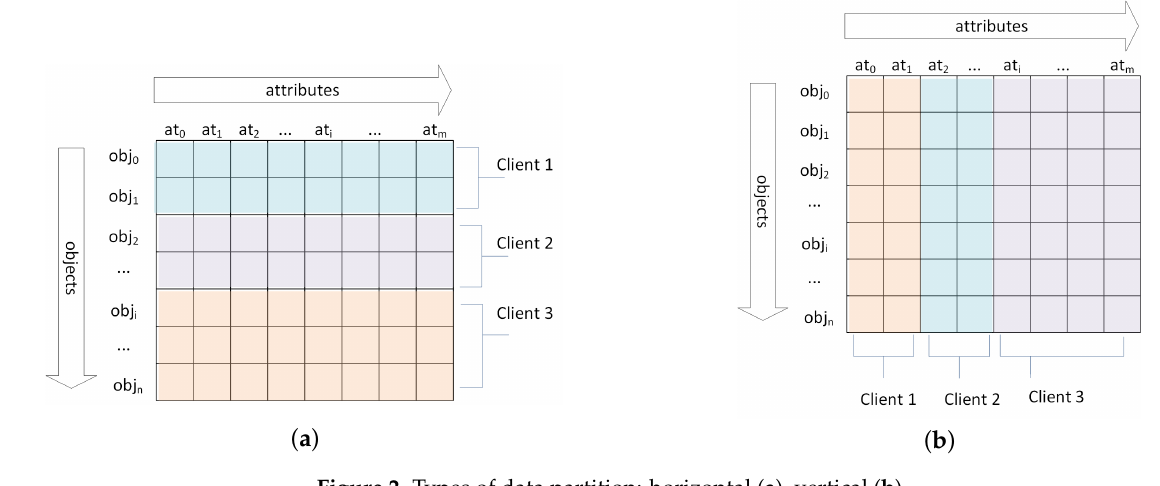
Figure 2. Types of data partition: horizontal ( a ), vertical ( b